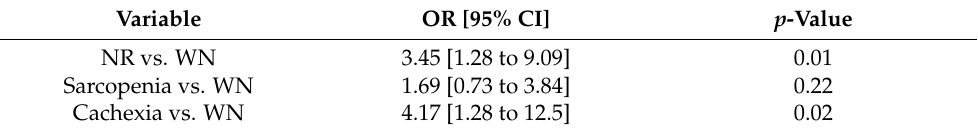
Figure 3. Distribution of actual and attributed HRQoL data six months after enrollment in each NS category according to the best-case scenario (all 21 patients not available for assessment for unknown reasons were attributed favorable HRQoL and all 27 patients not available for assessment for disease-related reasons were attributed unfavorable HRQoL). Table 2. Prognostic role of the baseline NS category for short-term estimated HRQoL.